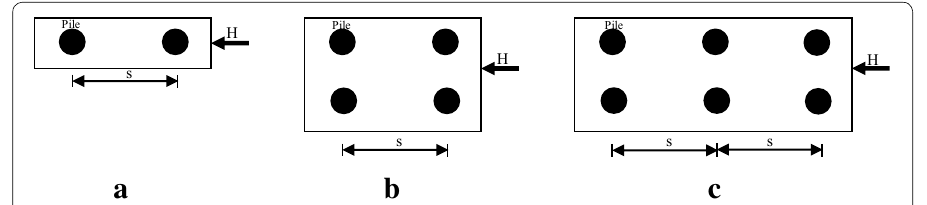
Fig. 2 Pile group configurations used in this study, a single row of pile (2 and c rectangular